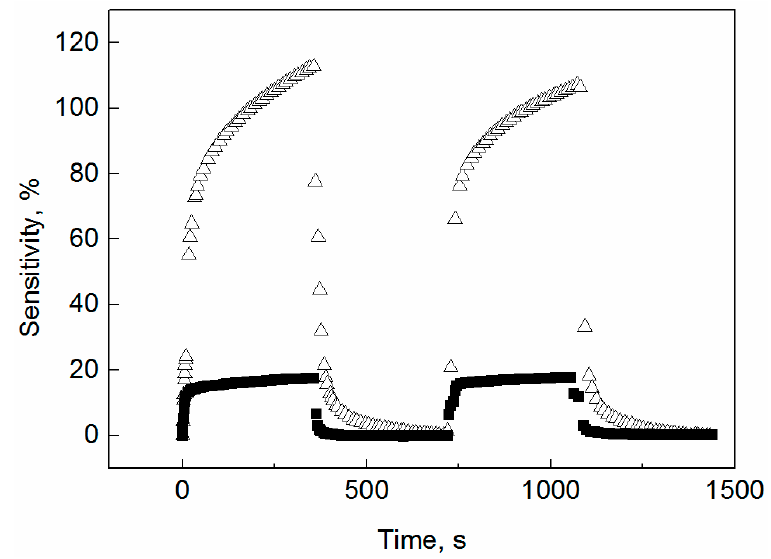
Figure 7. The response profile during two adsorption/desorption cycles in the presence of n- heptane (6.0 vol %) for ( (cid:52) ) polypyrrole nanotubes and ( (cid:4) ) carbonized polypyrrole nanotubes.